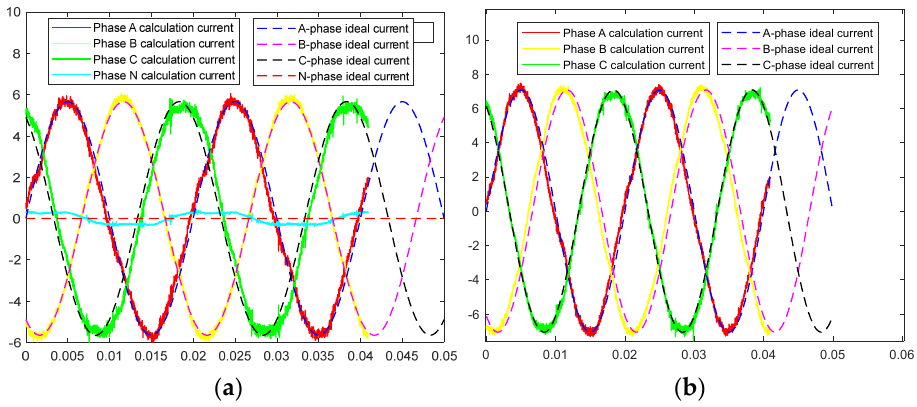
Figure 17. Di ff erent current reduction waveforms. ( a ) Restore waveform when current is 4 A; ( b ) Figure 17. Different current reduction waveforms. ( a ) Restore waveform when current is 4 A; restore waveform when current is 5 A. ( b ) restore waveform when current is 5